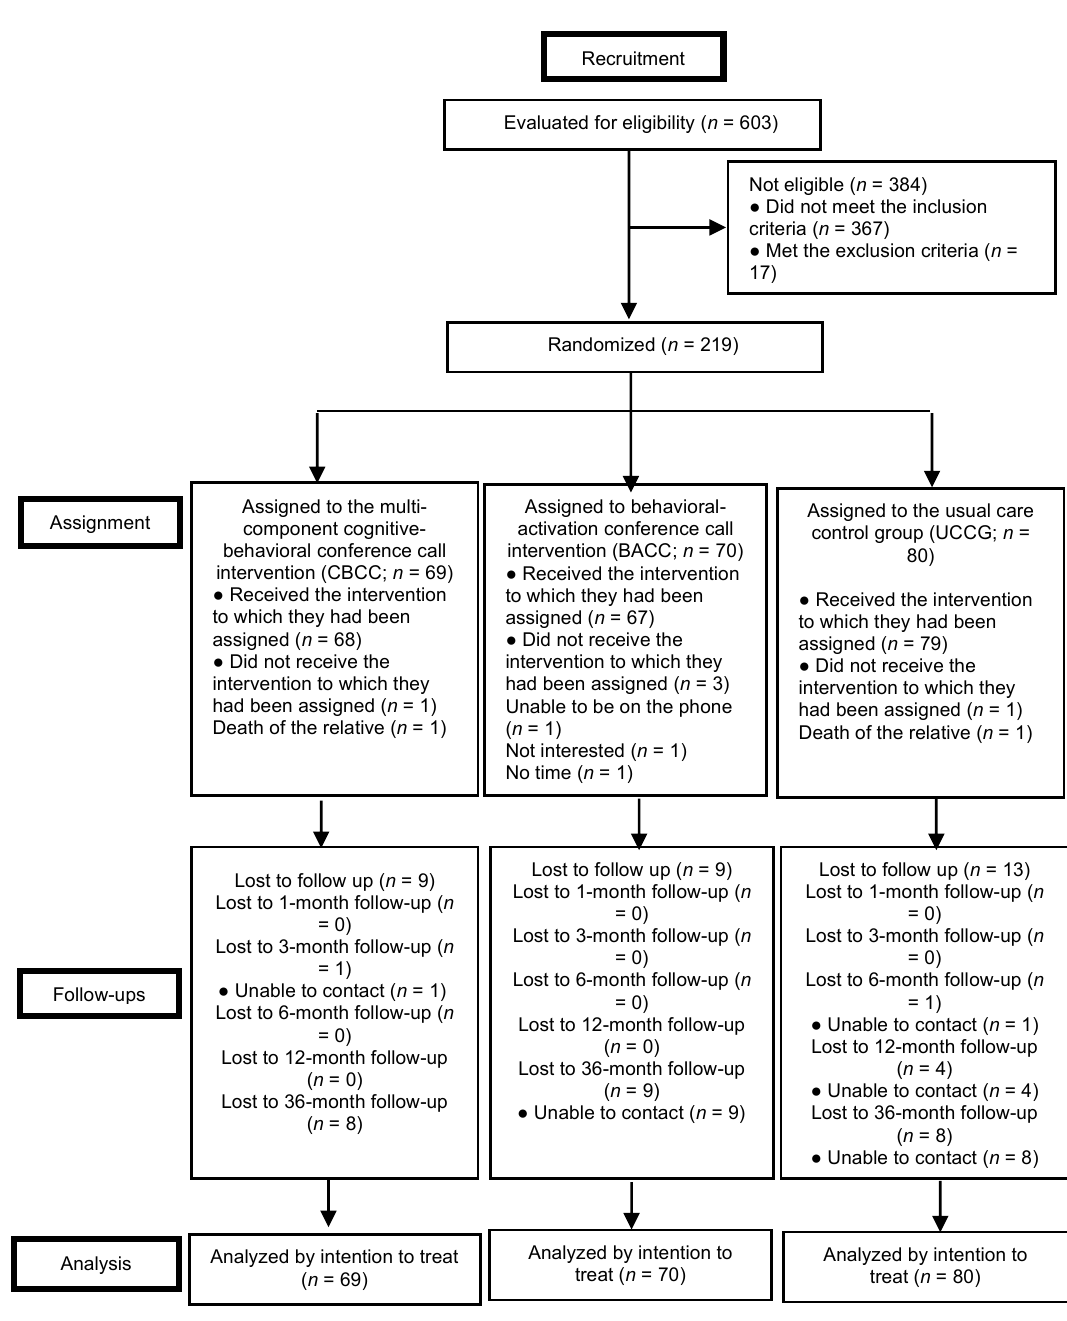
Figure 1. Figure 1. Flowchart.